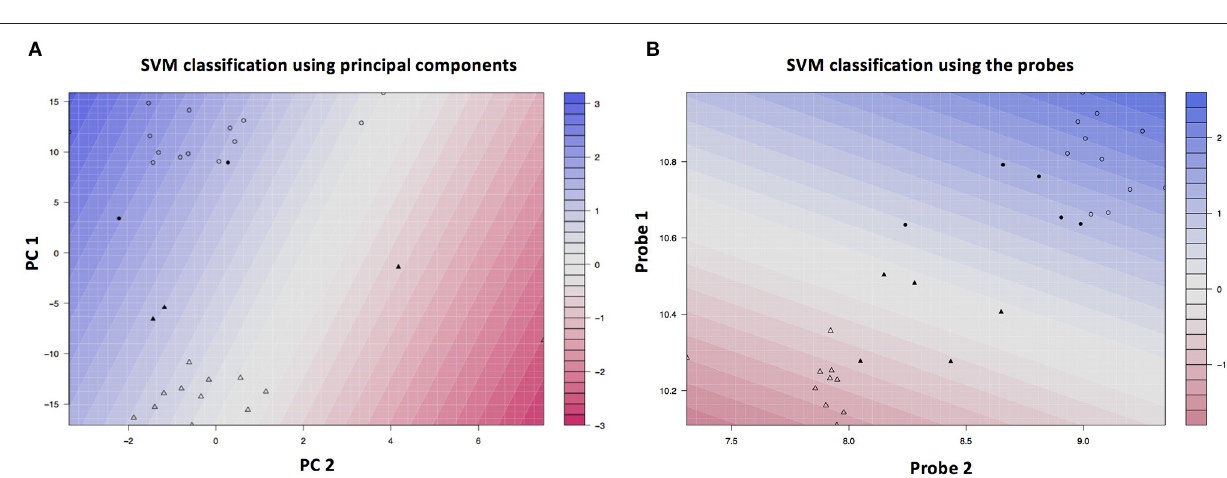
FIGURE 5 | SVM clustering results based on the top PCs. (A) Shows the color gradient that indicates how confidently a new point would be classified based on its features. PC1 and PC2 represent the first and second principal components, respectively. (B) Shows the color gradient that indicates how confidently a new point would be classified based on its features when predictors were based on all SCQ-associated probes. Probe 1 and probe 2 represent the first and second probes, respectively. The solid symbols indicate the support vectors and the hollow circles indicates other subjects. The circles and triangles represent the first and second subgroups,